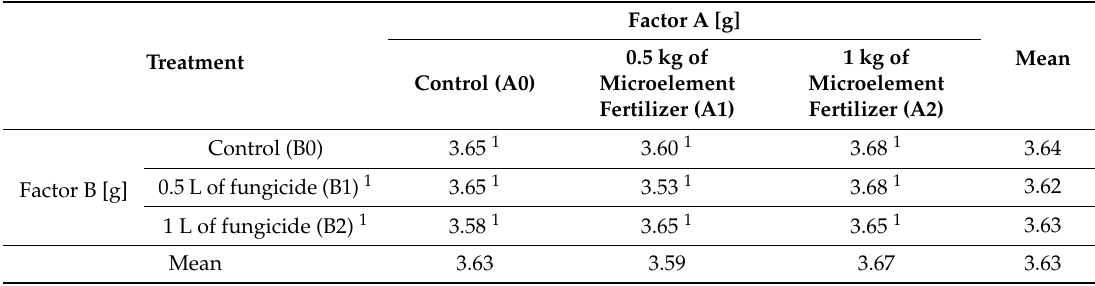
Table 3. E ff ect of micronutrients and fungicide on 1000 seeds’